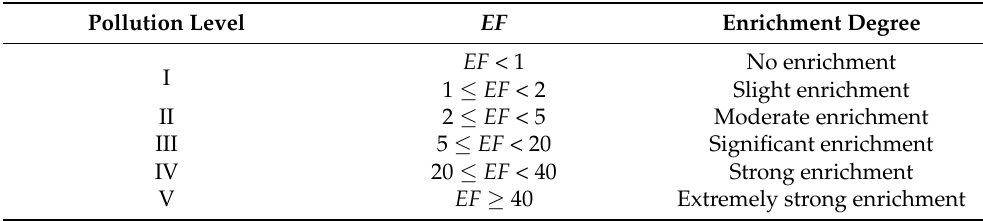
Table 1. EF classification criteria [15].